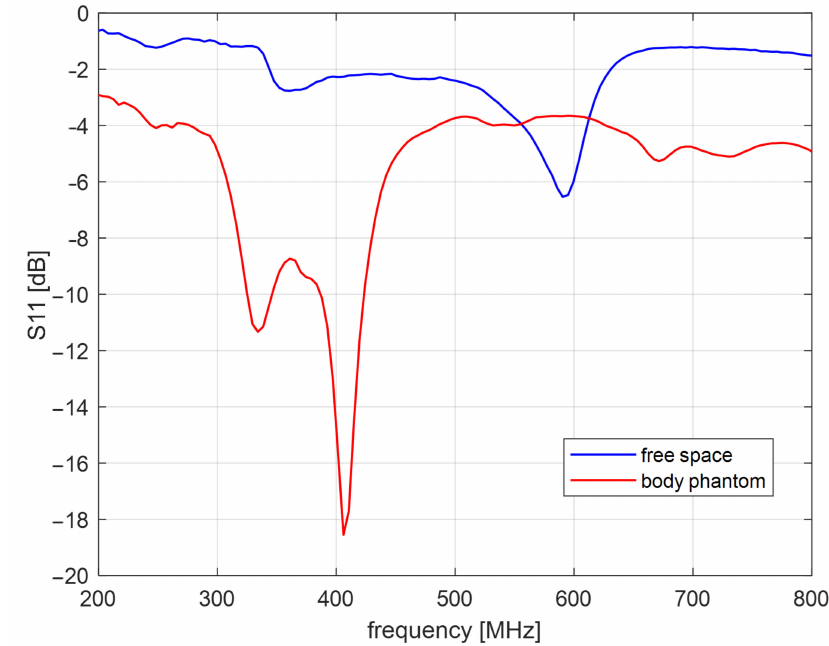
Figure 9. Impedance matching of the capsule antenna.